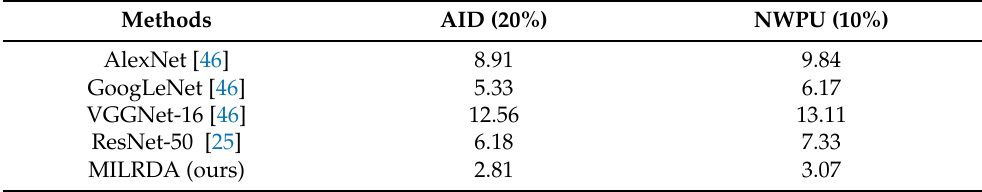
Table 6. Prediction times of different methods on two datasets (in milliseconds).